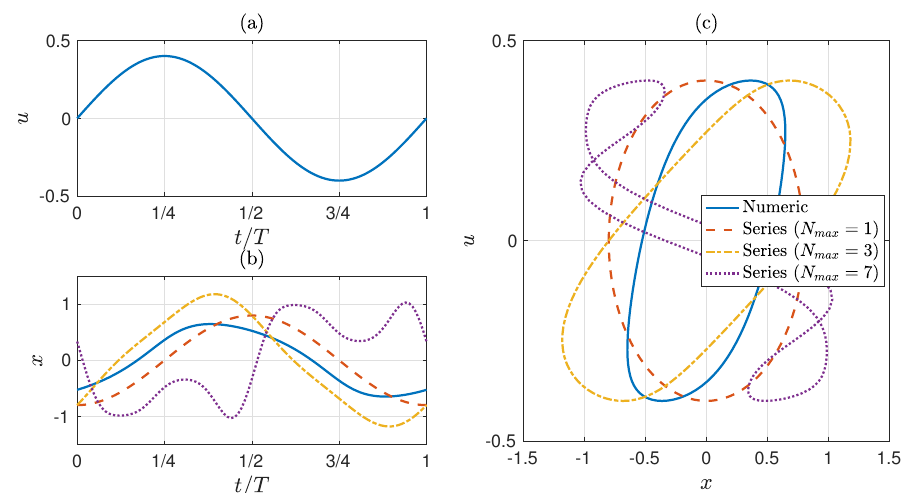
Figure 5. Comparison of system behavior predictions using numeric and analytic solution (54) for ω = 0.5, A = 0.4 and φ = 0 ( T = 2 π / ω ). ( a ) u vs. τ / T , ( b ) x vs. τ / T , and ( c ) phase plane ( x , u ) .